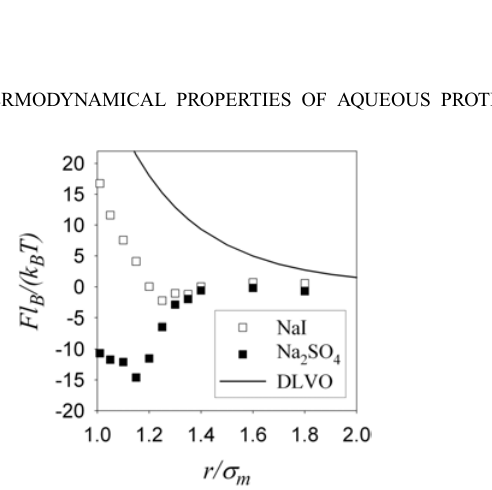
Fig. 1 – Total mean force between two macroions in monovalent and divalent electrolytes solution of ionic strength 0.125 M. Results are for NaI, Na 2 SO 4 , and classical DLVO theory (Tavares et al. 2004b).